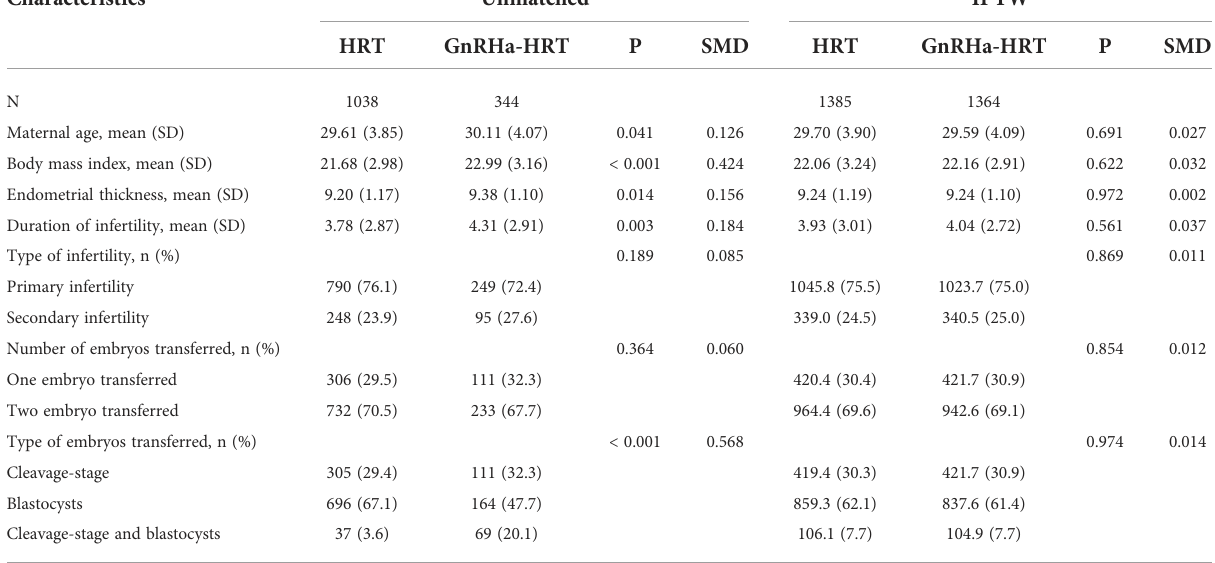
TABLE 1 Basic characteristics of unweighted and IPTW study populations.